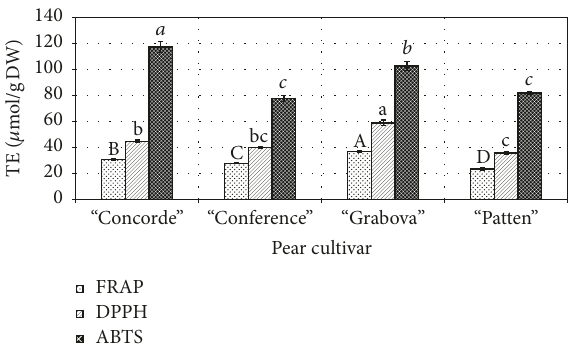
Figure 5: The antioxidant activity of pear extracts determined by using DPPH, ABTS, and FRAP assays. Values are means, and error bars indicate standard deviations ( 𝑛 = 3 ). The different letters indicate significant differences in the values between pear cultivars ( 𝑝 < 0.05